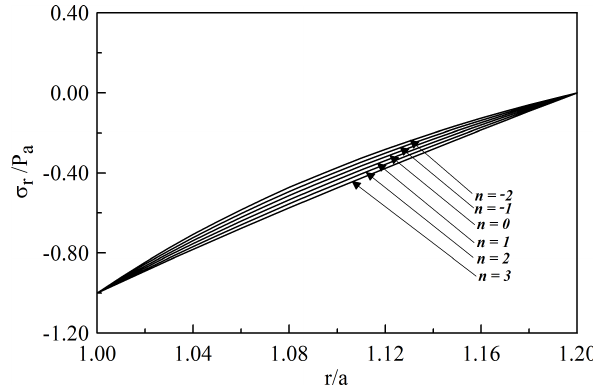
1.084(approx.),thesituationisreversedandthevon-Mises stress increases as the grading parameter increases.